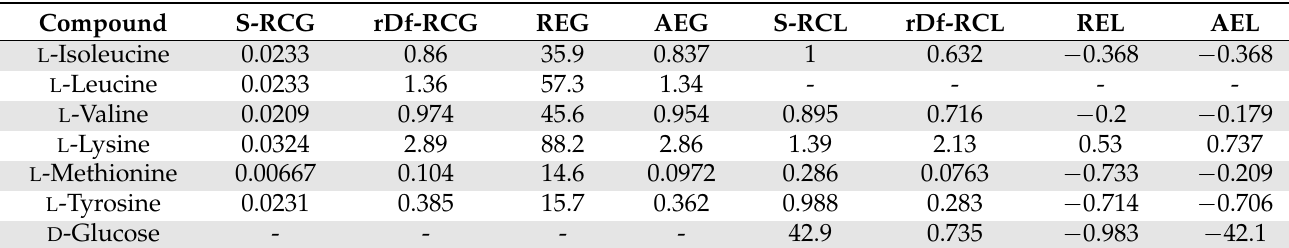
Table 6. Results from the rDolphin quantifier with the fecal profile. The column headings are defined for this quantifier (with prefix rDf- ) analogous to the caption of Table 3. Compound